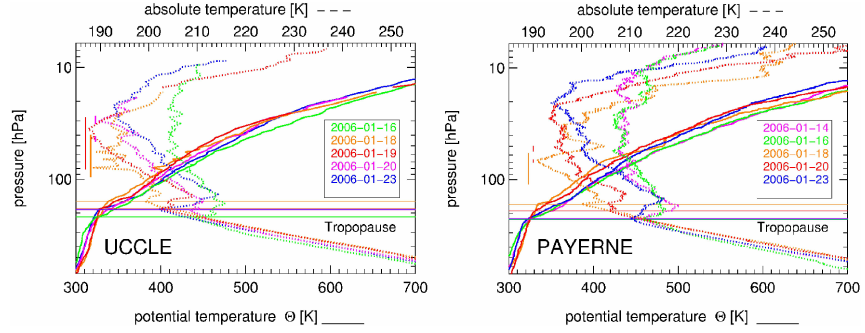
Fig. 4. Height profiles for Uccle (left panel) and Payerne (right panel) of potential temperature (lower x -axes, solid lines) and absolute temperature (upper x -axes, dotted lines), for same days as in Figs. 2 and 3; tropopauses were calculated following WMO criteria; vertical lines mark altitudes where the threshold for existence of PSCs of nitric acid trihydrate was